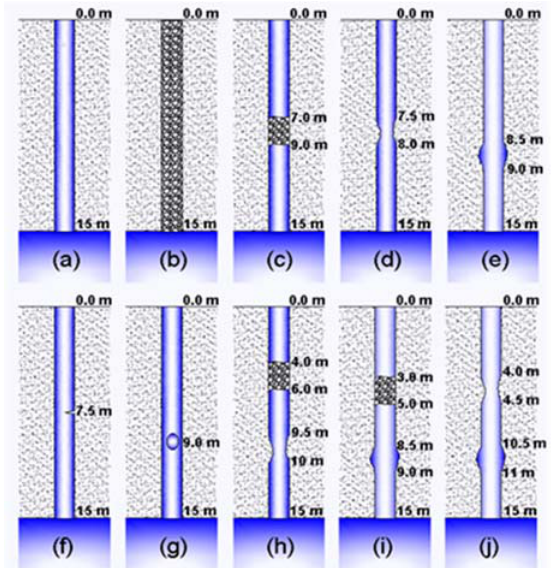
Figure 8. Various cases of intact and defective piles simulated by FEM: ( a ) Intact and uniform pile; ( b ) Pile with weak concrete throughout the length; ( c ) Weak concrete at a section; ( d ) Neck defect; ( e ) Bulge imperfection; ( f ) Notch, crack, or break; ( g ) Void; ( h – j ) Multiple